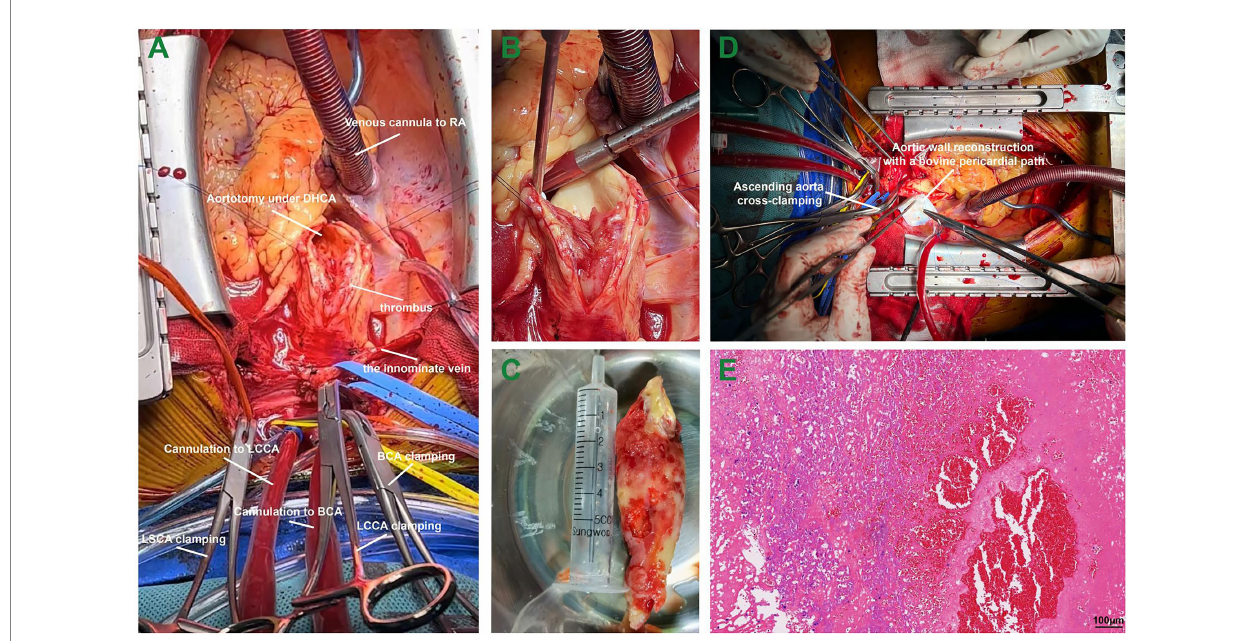
FIGURE 2 The surgical procedure in a patient with a giant thrombus from the ascending aorta to the arch. Panel A , the cannulation strategies for bilateral cerebral perfusion; Panel B , the giant floating thrombus attached to the aortic wall of the ascending aorta; Panel C , the giant thrombus measuring 9*4 cm in size; Panel D , the aortic wall reconstruction using a bovine pericardial patch; and Panel E , pathological evaluation of the thrombus in hematoxylin and eosin staining. Abbreviations: RA, right atrium; DHCA, deep hypothermic circulatory arrest; BCA, brachiocephalic artery; LCCA, left common carotid artery; LSCA, left subclavian